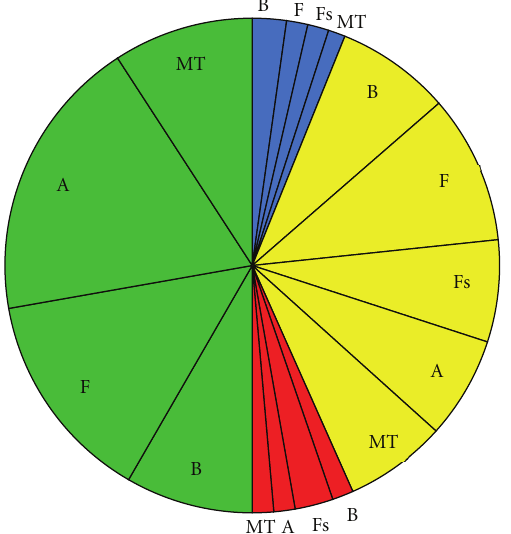
Figure 3: Pie chart representing the proportion of impacts for each ecosystem component for Impact scenario i2, wind turbine projects involving pile driving, categorized by whether the e ff ect is positive (blue), minor negative (green), moderate negative (yellow), or major negative (red). B = Benthic habitat and resources; F = Fish; Fs = Fisheries; A = Avian species; MT = Marine mammals and sea turtles.